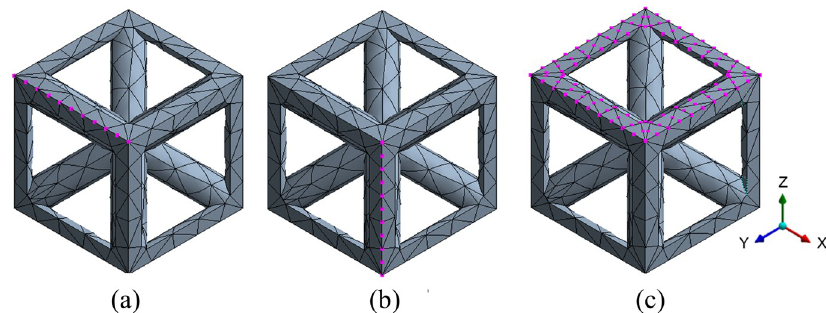
Figure 6. Selections of sets of nodes in a cubic unit cell: ( a ) top left edge nodes, ( b ) front left edge nodes, and ( c ) top face edge nodes.